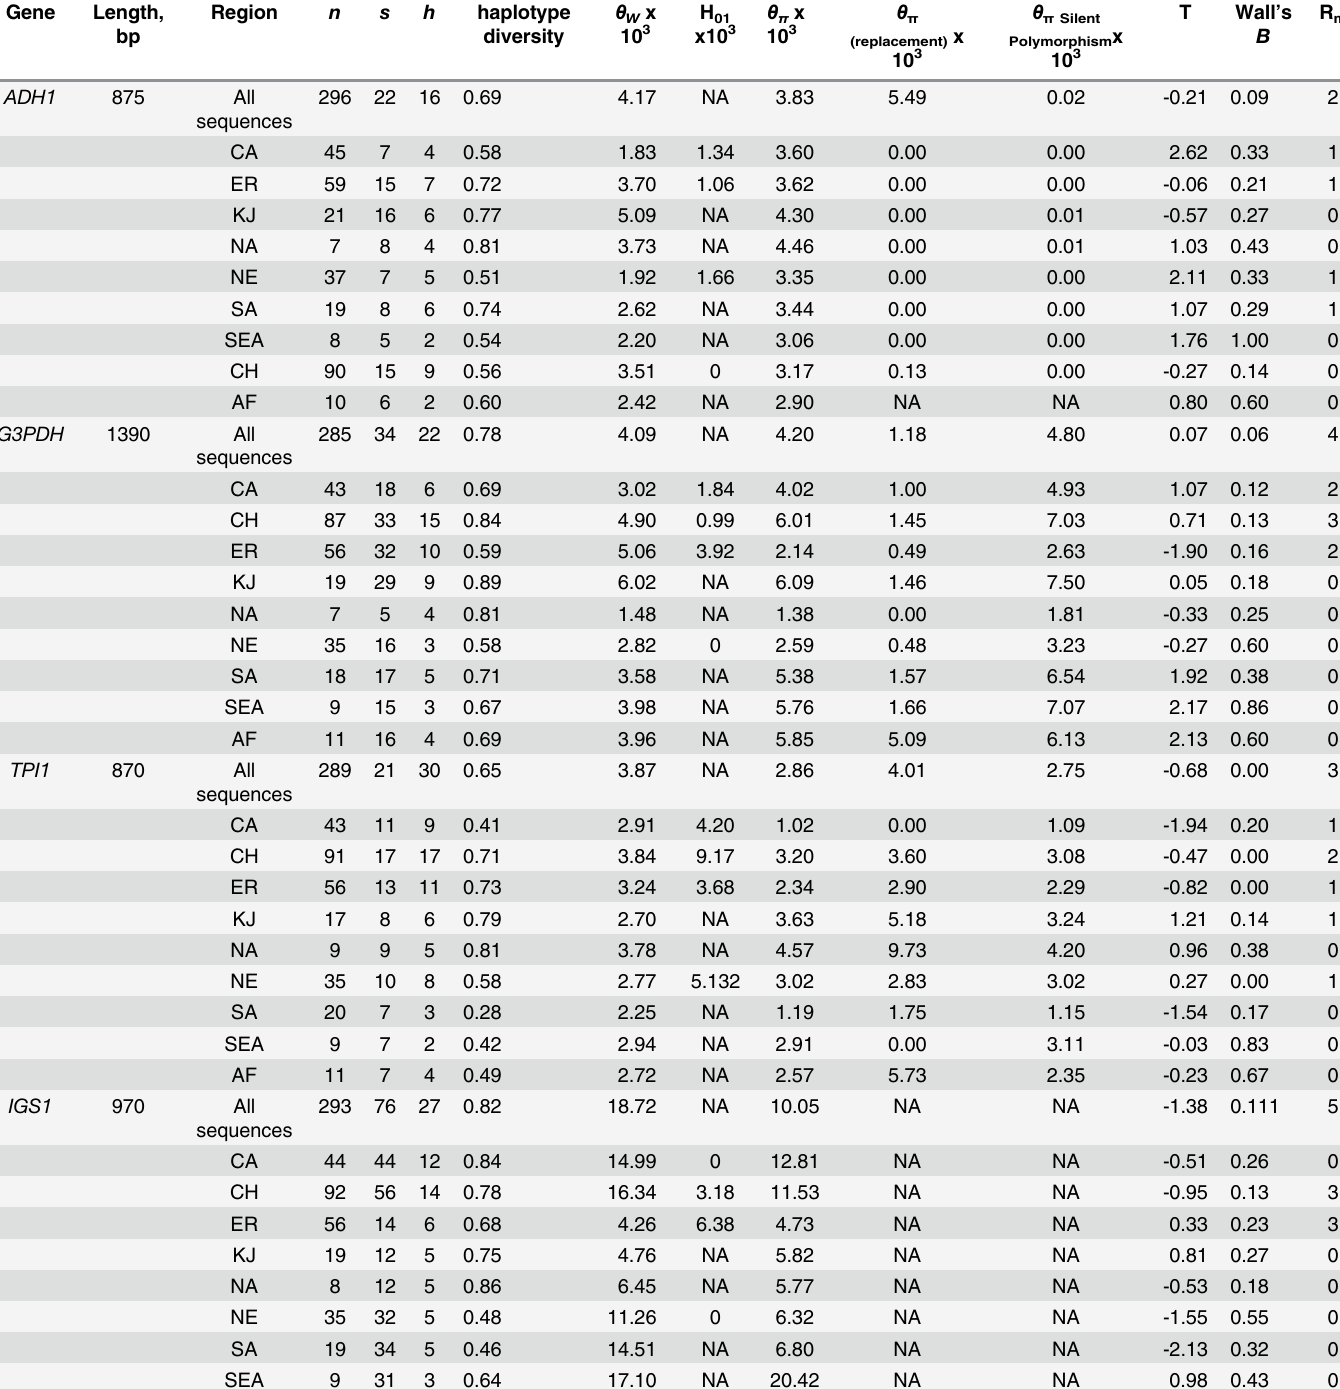
Table 2. Estimate of nucleotide sequence diversity, Tajima ’ s T (commonly reported as Tajima ’ s D test), Wall ’ s B , and R m for 311 accessions of fox- tail millet. Gene Length, Region n s h bp ADH1 875 All sequences